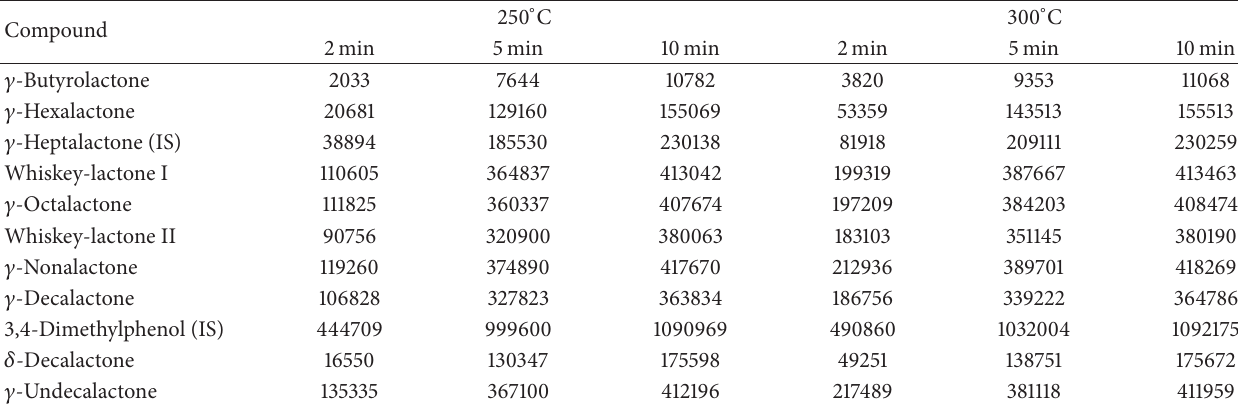
Table 4: Normalized peak areas at different temperatures and desorption